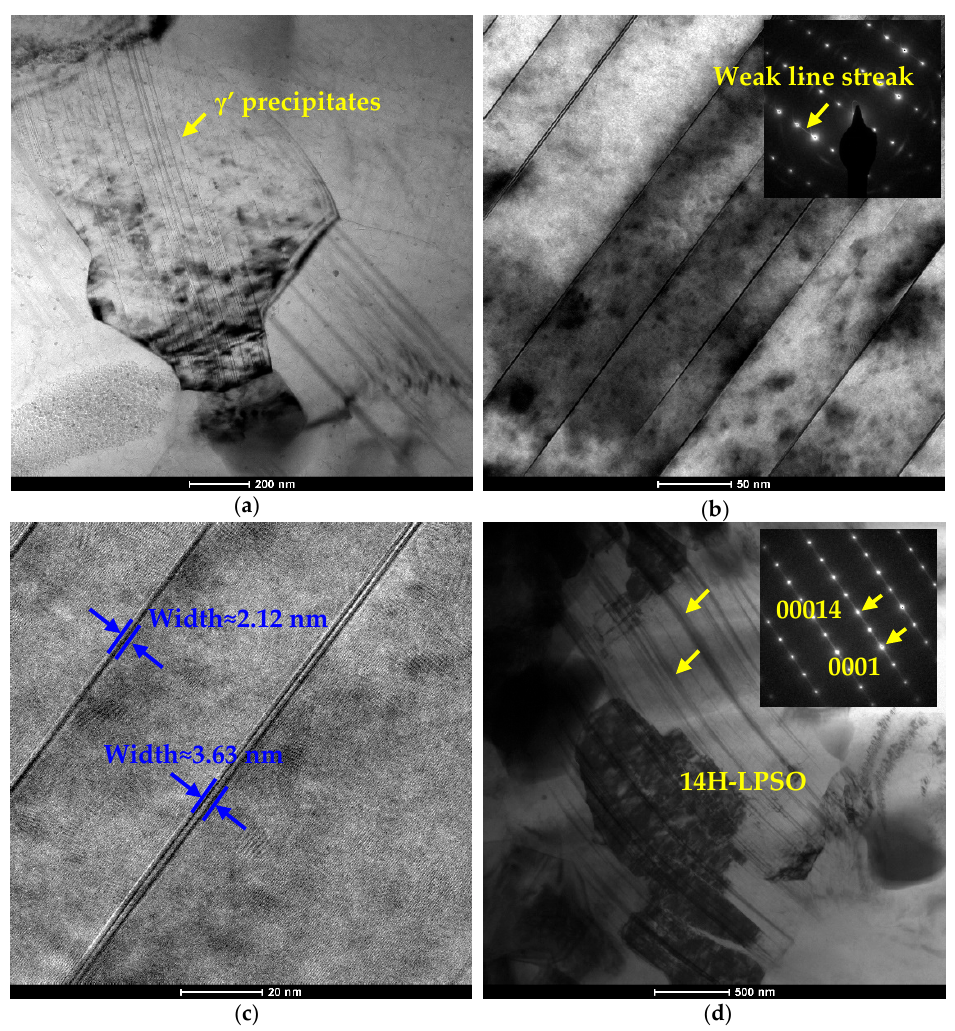
Figure 8. TEM images of T6 over aged Mg-10Y-6Gd-1.5Zn-0.5Zr alloy. ( a ) Grown lamellar γ ’ precipitates across α -Mg grains; ( b ) Enlargement of the lamellar γ ’ precipitates and inset was the corresponding selected area electron diffraction (SAED) pattern; ( c ) High resolution (HR) TEM image of the lamellar γ ’ precipitates; ( d ) Lamellar 14H-LPSO phase and inset was the corresponding SAED pattern.